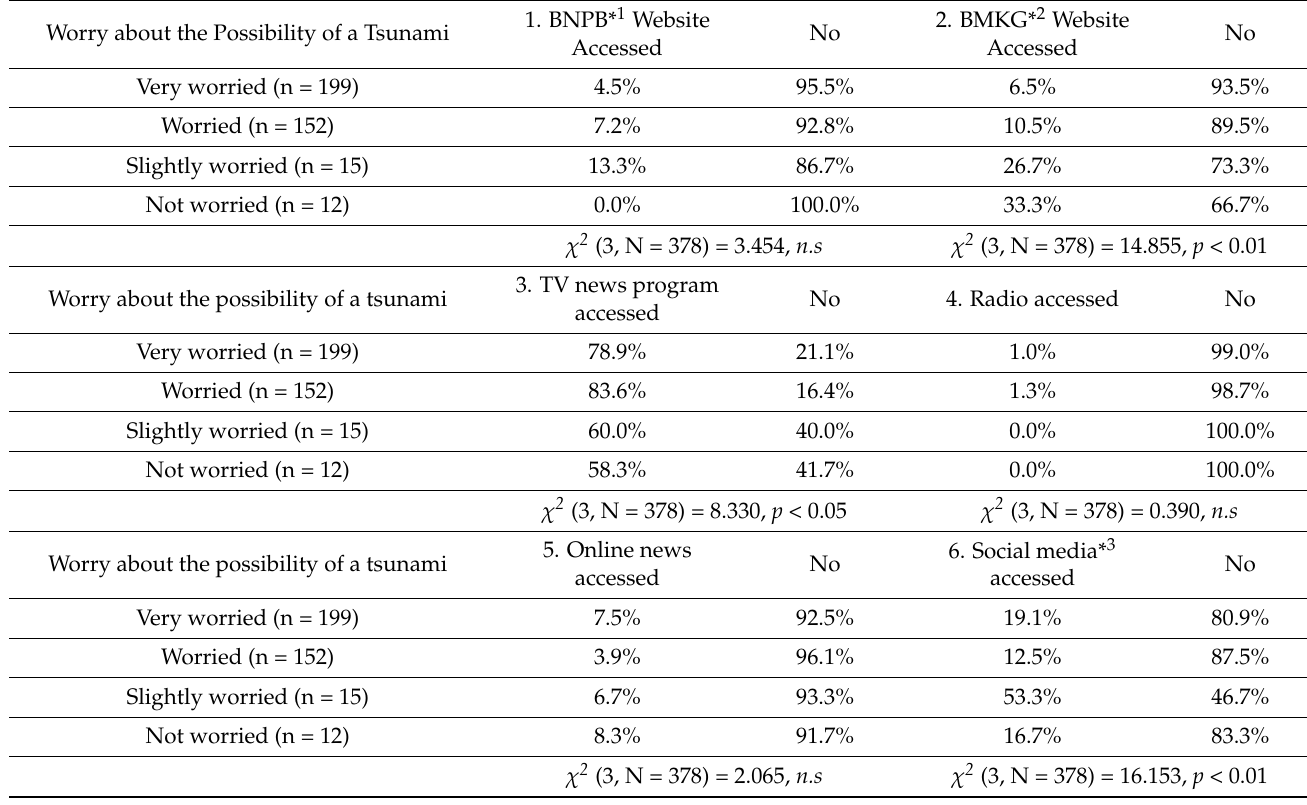
Table 12. Information access and worry about the possibility of a tsunami (N =